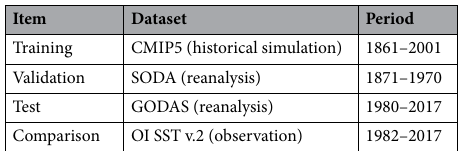
Table 1. Description of